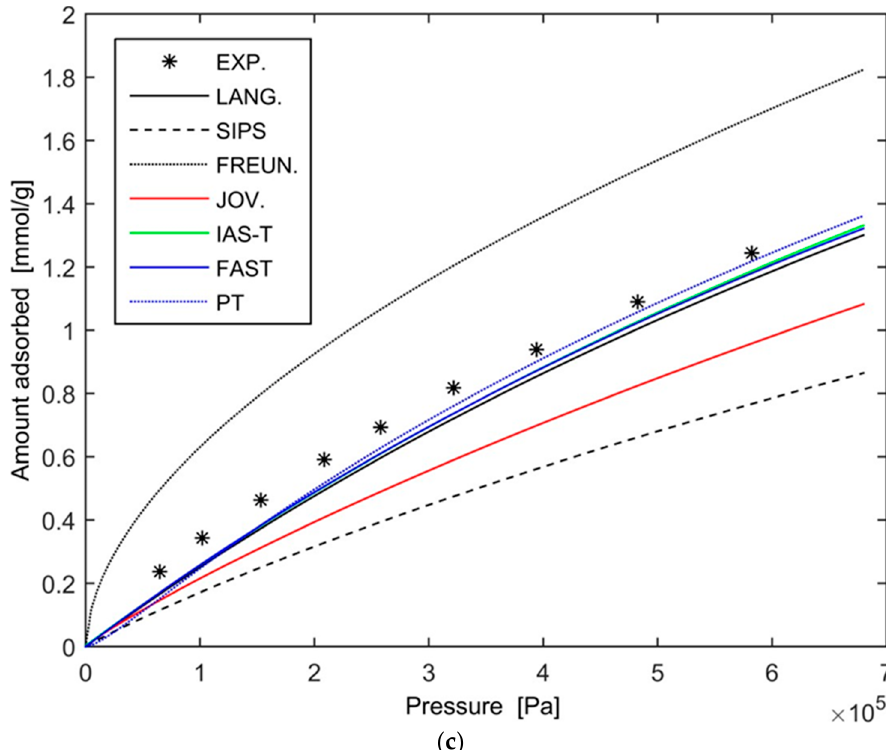
Figure 5. ( a ) Adsorption results of hydrogen gas from mixture corresponding to case N° 5; ( b ) Adsorption results of nitrogen gas from mixture corresponding to case N° 5; ( c ) Adsorption results of methane gas from mixture corresponding to case N° 5.